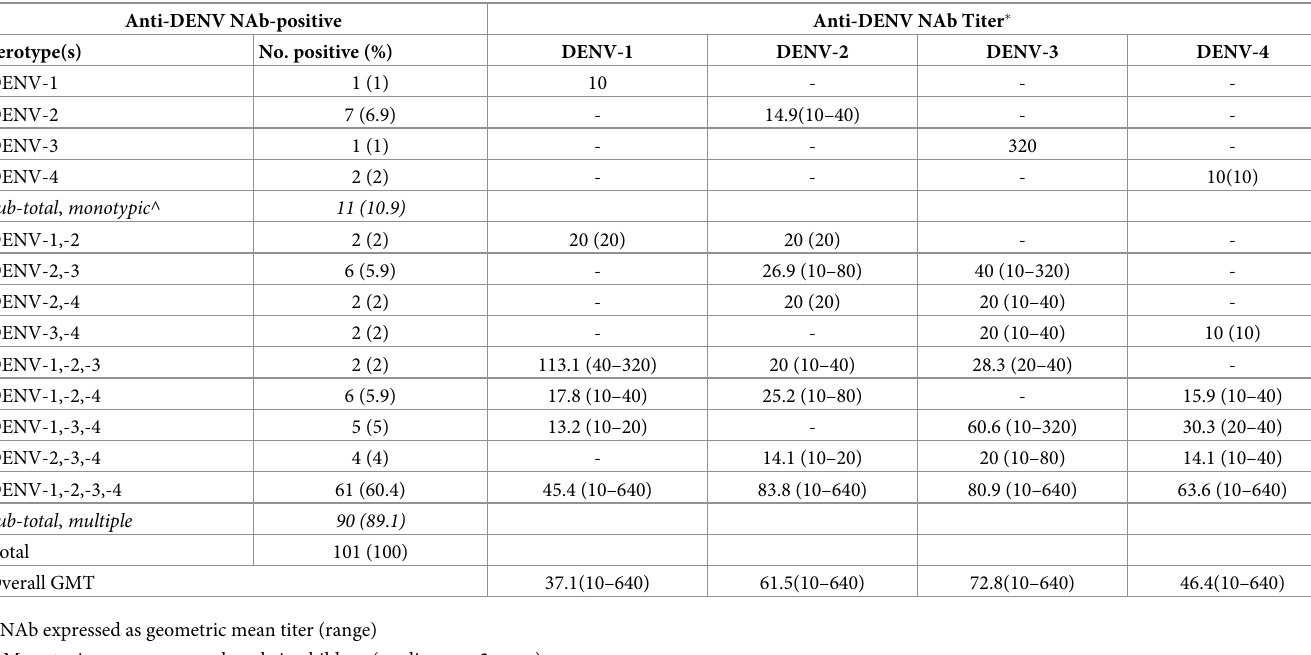
Table 4. Anti-DENV neutralizing antibody profiles,